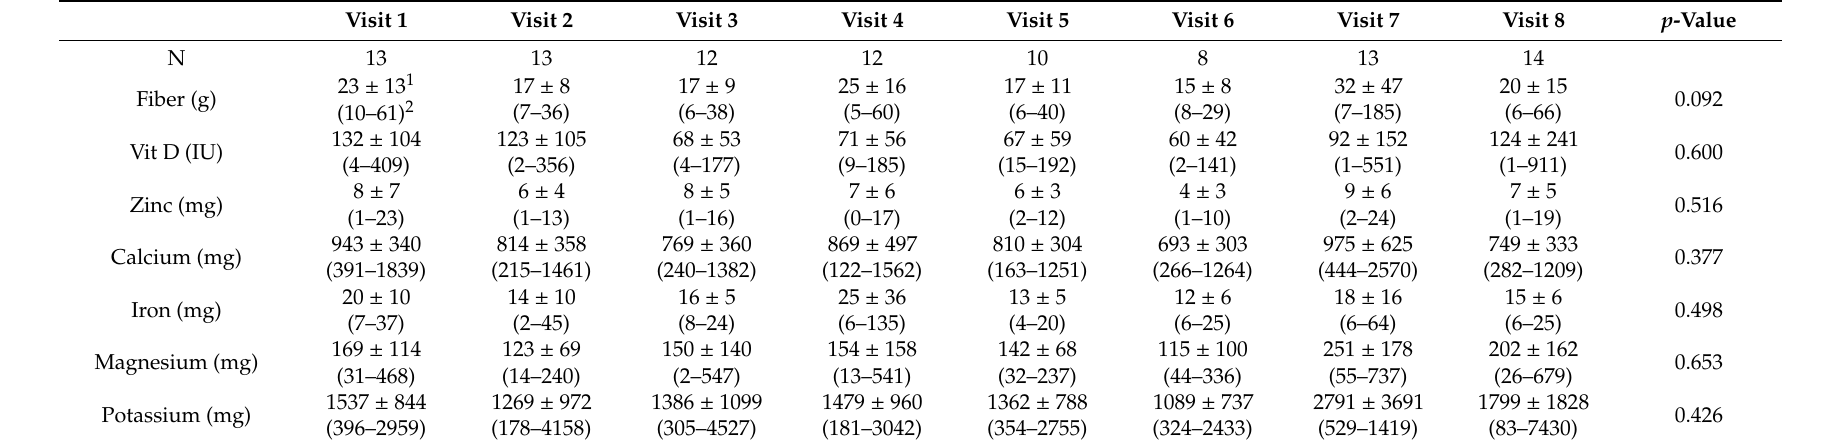
Table 4. Micronutrient